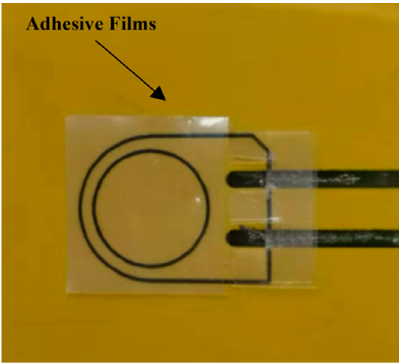
Figure 1. Schematic of the pre ‐ bonding procedure.